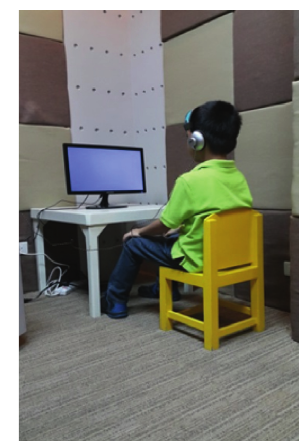
Figure 2: Typical experimental procedures (photo released with